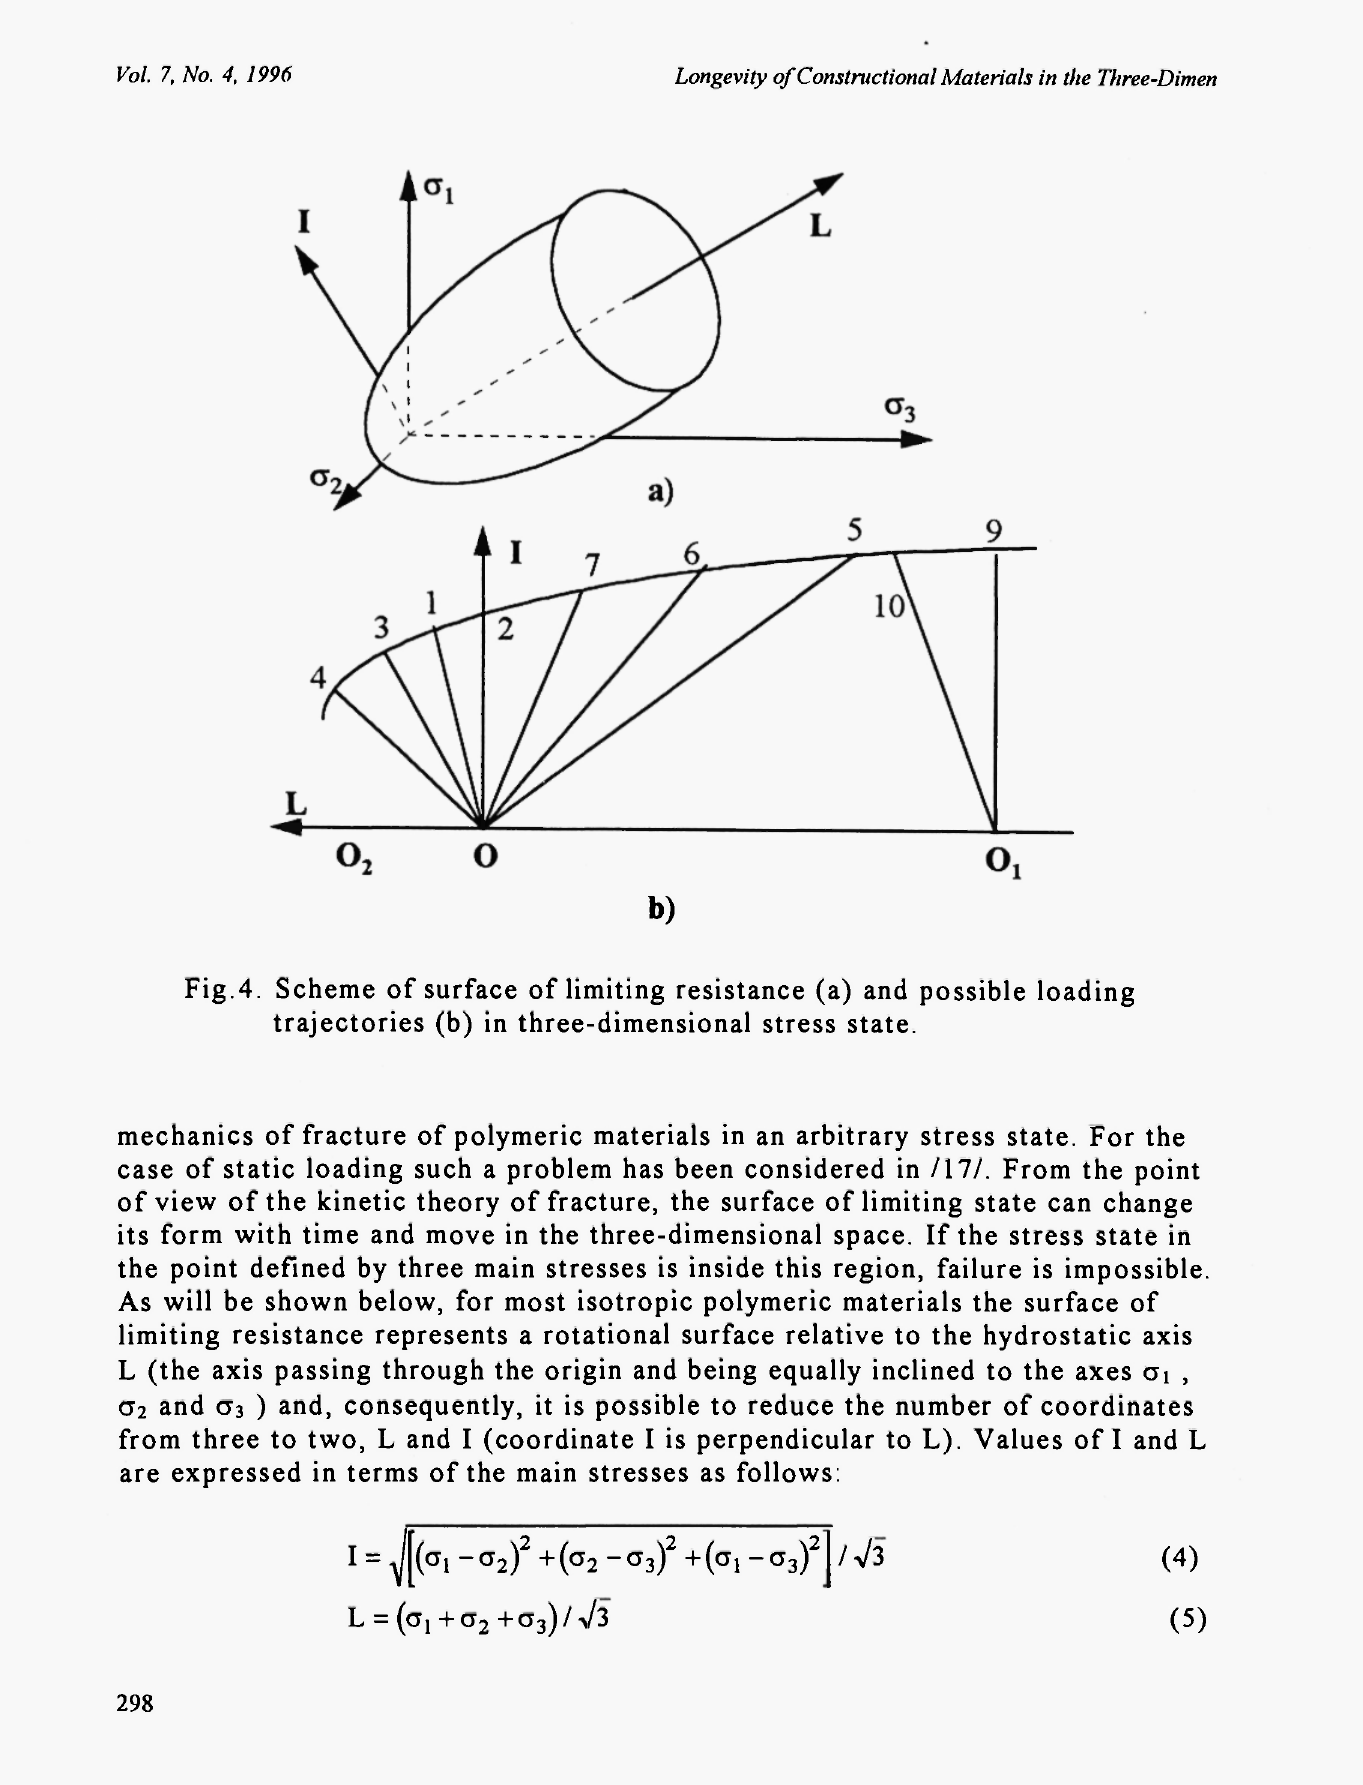
Fig.4. Scheme of surface of limiting resistance (a) and possible loading trajectories (b) in three-dimensional stress